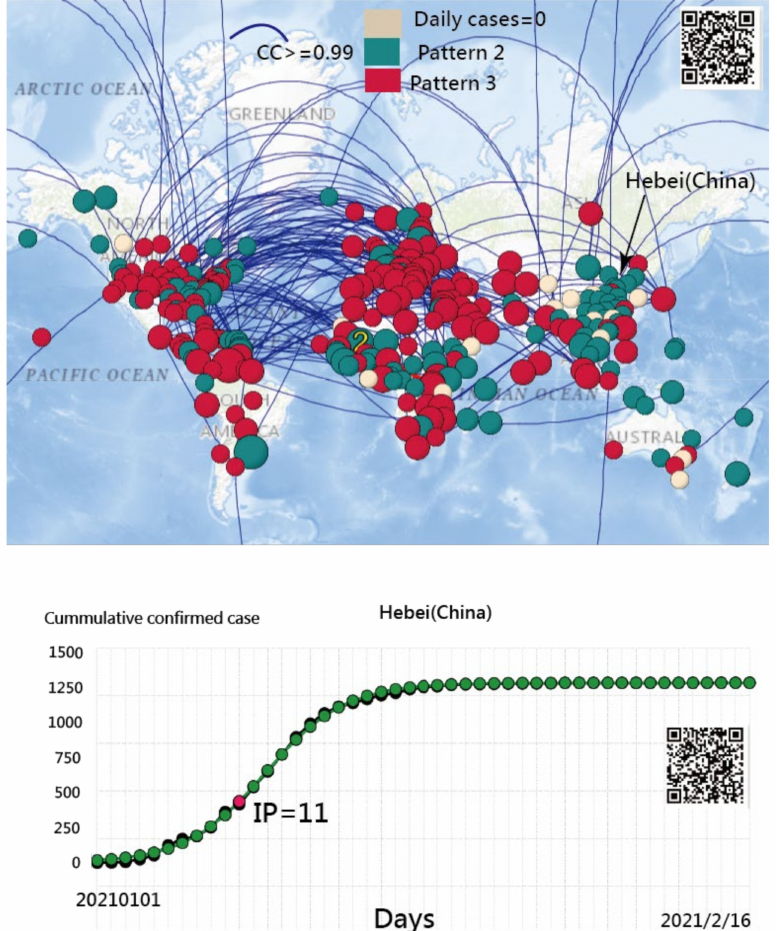
Figure 8. Spread patterns of COVID-19 in countries/regions using CCs (a = 0.99, b = − 2.48) (Note: readers are invited to scan the QR-code to examine the detail on a